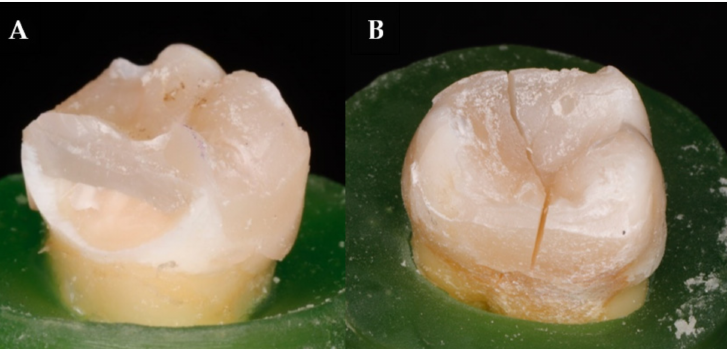
Figure 4. Examples of failed specimens. Picture ( A ) shows a favorable repairable fracture (in the case of SFRC), while picture ( B ) shows an unfavorable, irreparable fracture going through the direct restoration (lack of